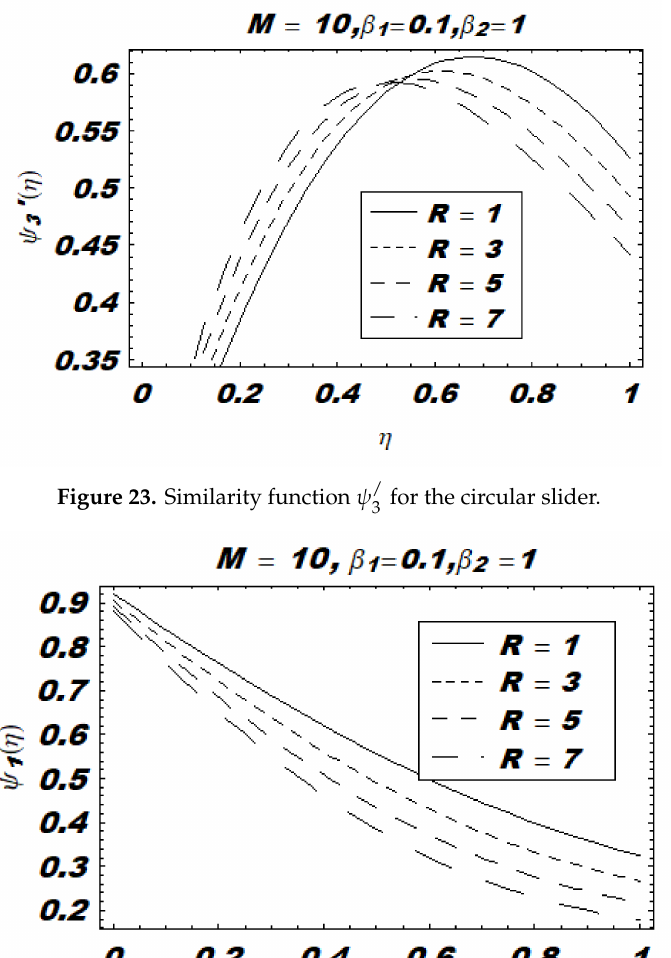
Figure 24. Similarity function ψ 1 for the circular slider.